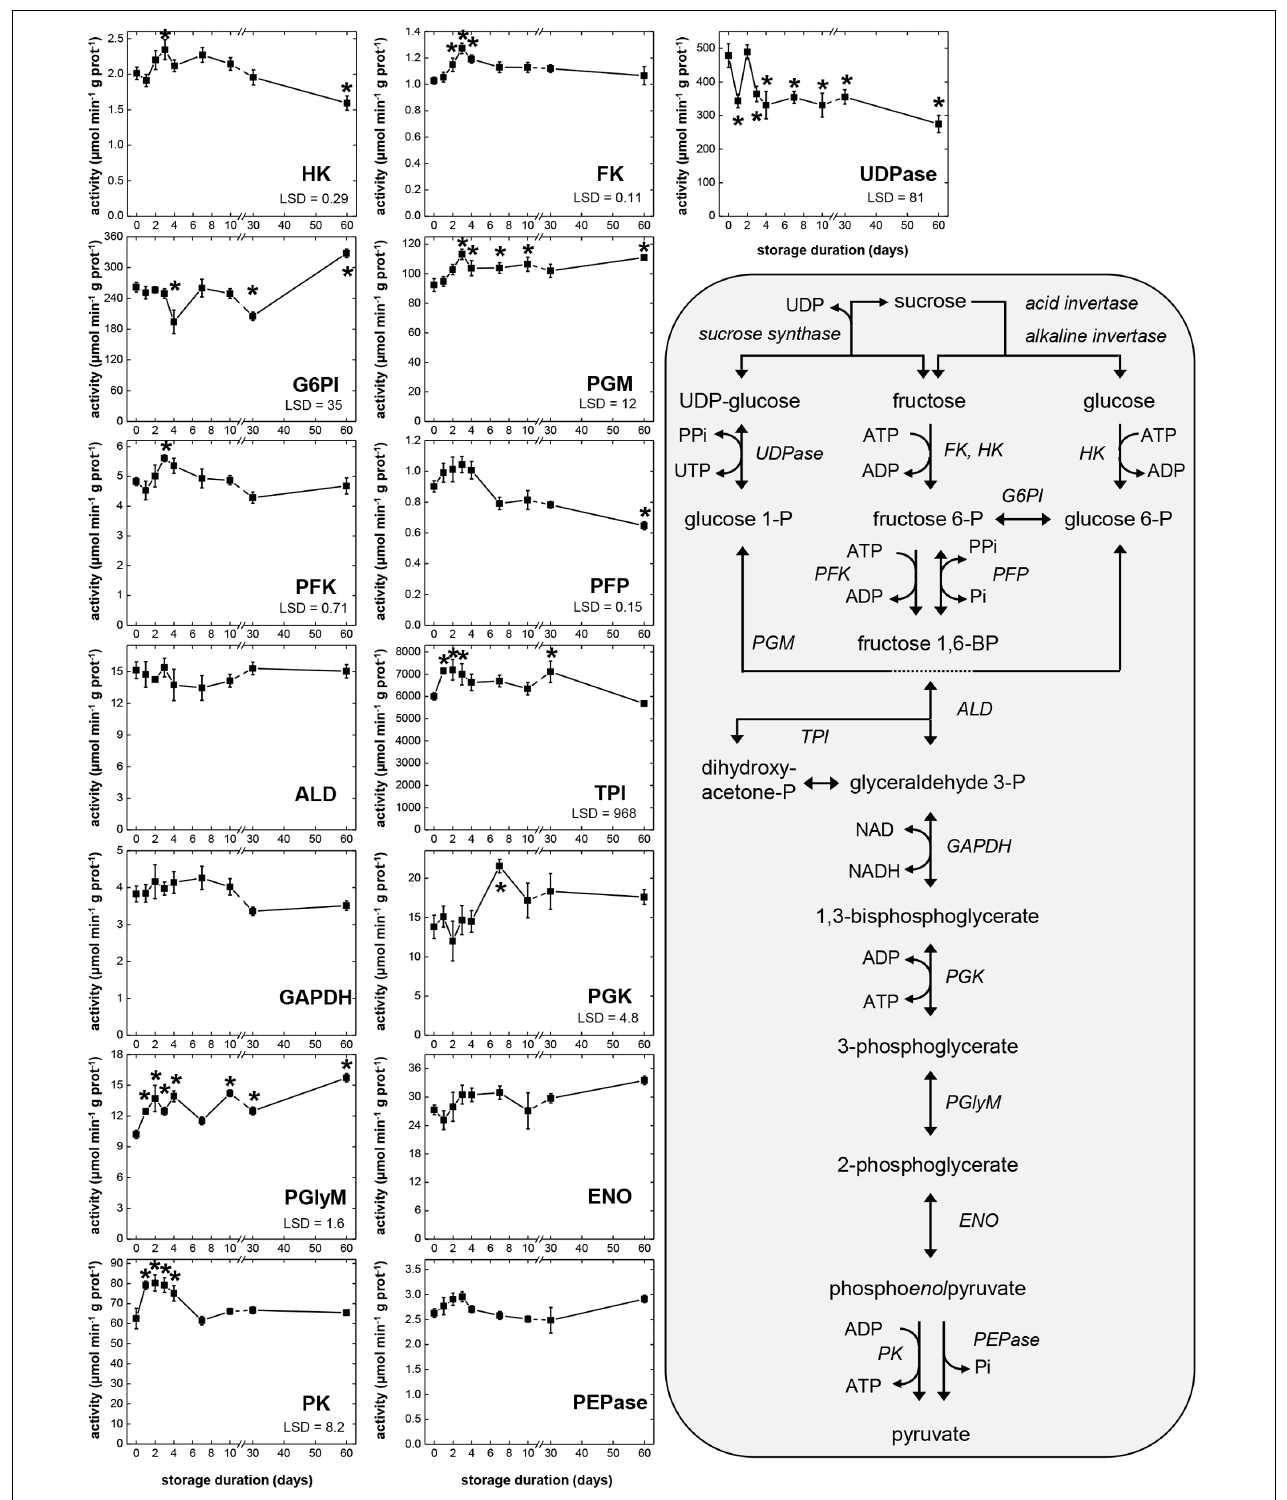
FIGURE 2 | Glycolytic enzyme activities in sugarbeet roots during 60 days storage and schematic of glycolytic reactions. Roots were stored for 10 days at 10 ◦ C and 90 ± 5% RH, then stored at 4 ◦ C, 90 ± 5% RH for 50 days. All activities are expressed as µ mol min − 1 g − 1 protein. Abbreviations for enzymes are provided in Table 1 . Error bars are ± 1 standard error of the mean, where n = 7. Fisher’s least significant differences (LSDs) are provided in lower left corner of graphs with α = 0.05. Asterisks denote data that are significantly different from that at 0 days.